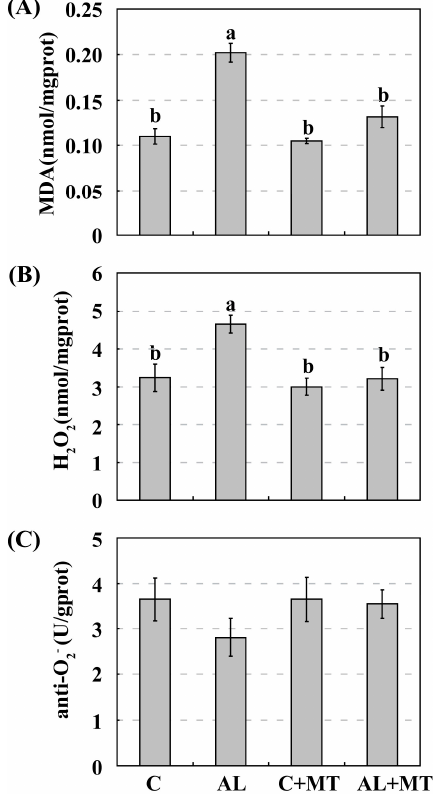
Figure 5. Accumulations of malondialdehyde (MDA) ( A ), hydrogen peroxide (H 2 O 2 ) ( B ), and superoxide anion (O 2 − ) ( C ) in Malus hupehensis Rehd. seedlings exposed to alkaline stress, with or without melatonin treatment. The accumulation of O 2 − was indicated by anti- O 2 − activity, which was negatively correlated with the accumulation of O 2 − . Lower-case letters indicate significant differences among treatments, based on Duncan’s multiple range test ( p < 0.05).